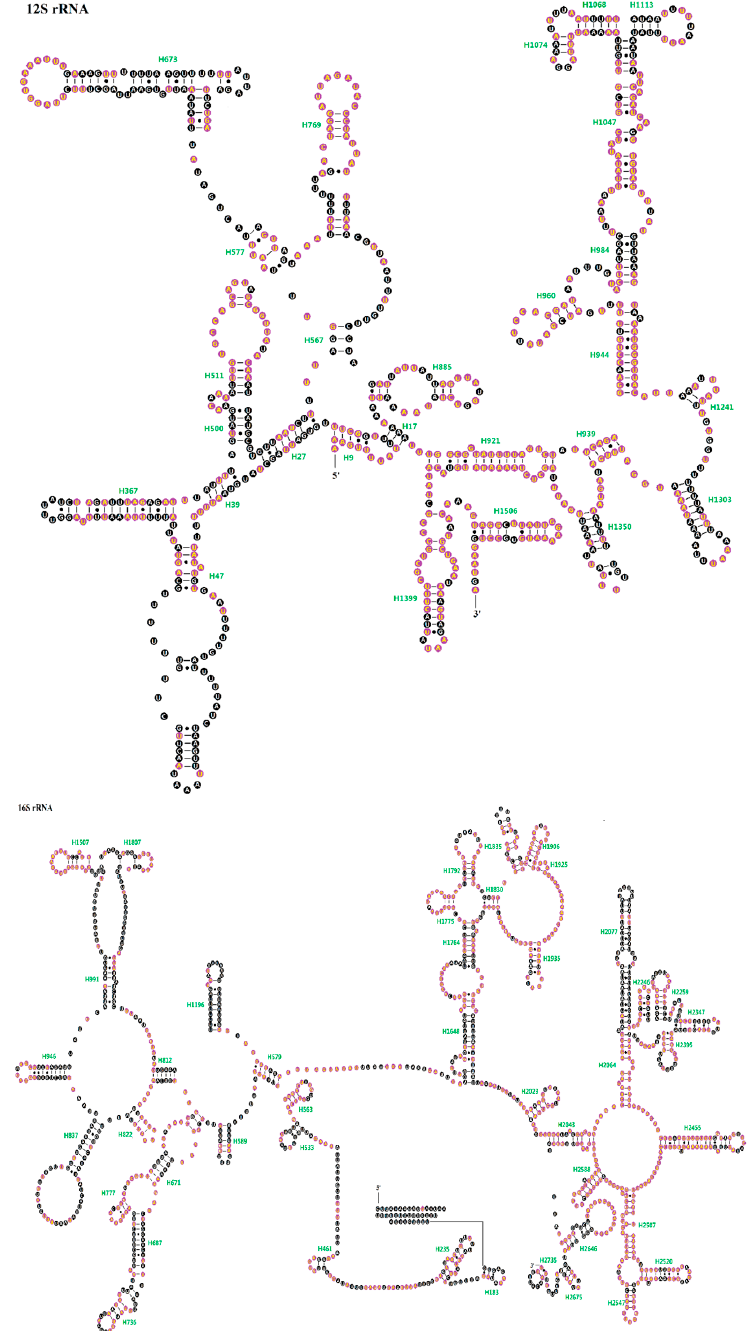
Figure 5. Inferred secondary structure for two ribosomal RNAs ( 12S rRNA and 16S rRNA ) in the T. molitor (Te2) mitogenome. Completely conserved sites within the ten Tenebrionidae specimens were marked by yellow nucleotides within a purple sphere. Bars denote Watson-Crick base pairings, and dots denote G-U base pairings.